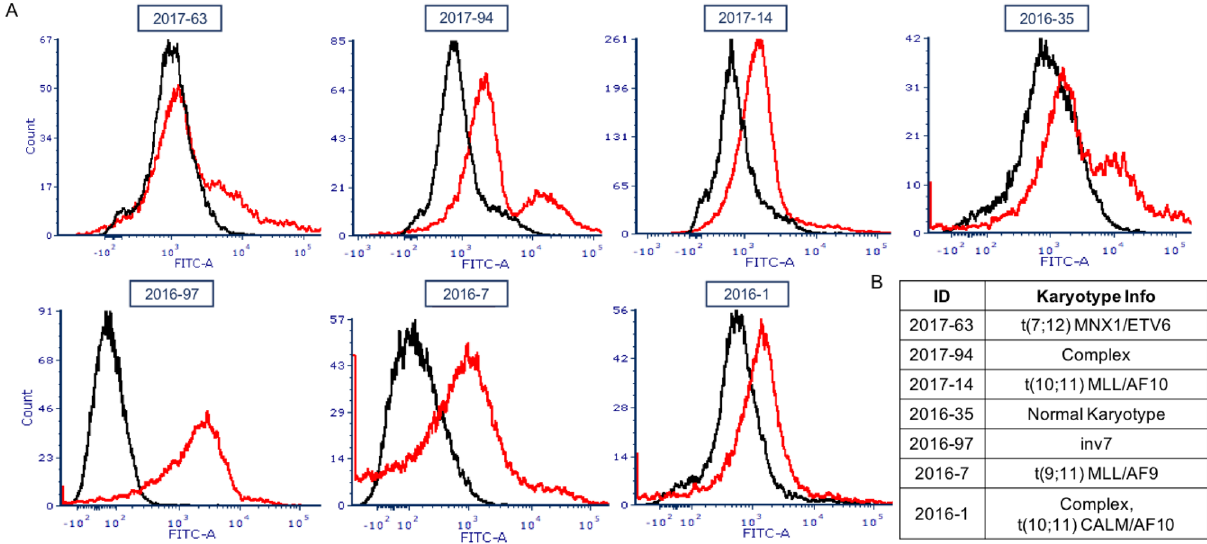
Figure 7. KGE02 binding to primary AML patient samples. ( A ) Mean of fluorescence intensity histograms of different AML primary patient samples (black) incubated with 200 nM KGE02 aptamer (red). Samples were incubated for an hour and 10,000 events were counted by flow cytometry. Data was analyzed using FCS Express software. ( B ) Table of the specific karyotype mutation of the primary patient